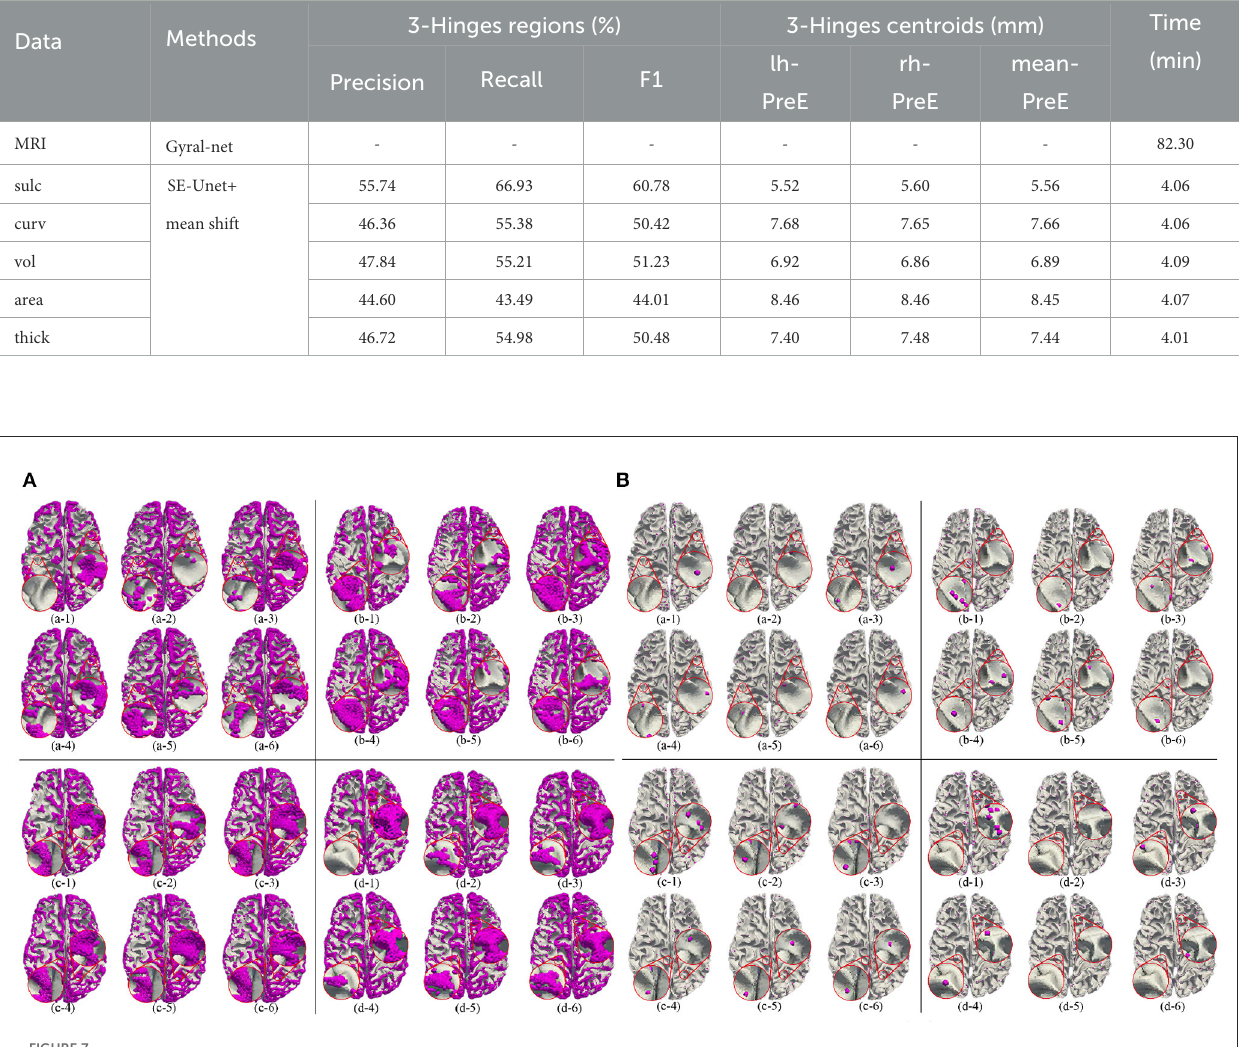
FIGURE7 3-Hinges regions (A) /centroids (B) visualized results using different features. Letters (a–d) represent different individuals. Numbers (1–6) indicate label, area, curv, sulc, thickness, and volume,